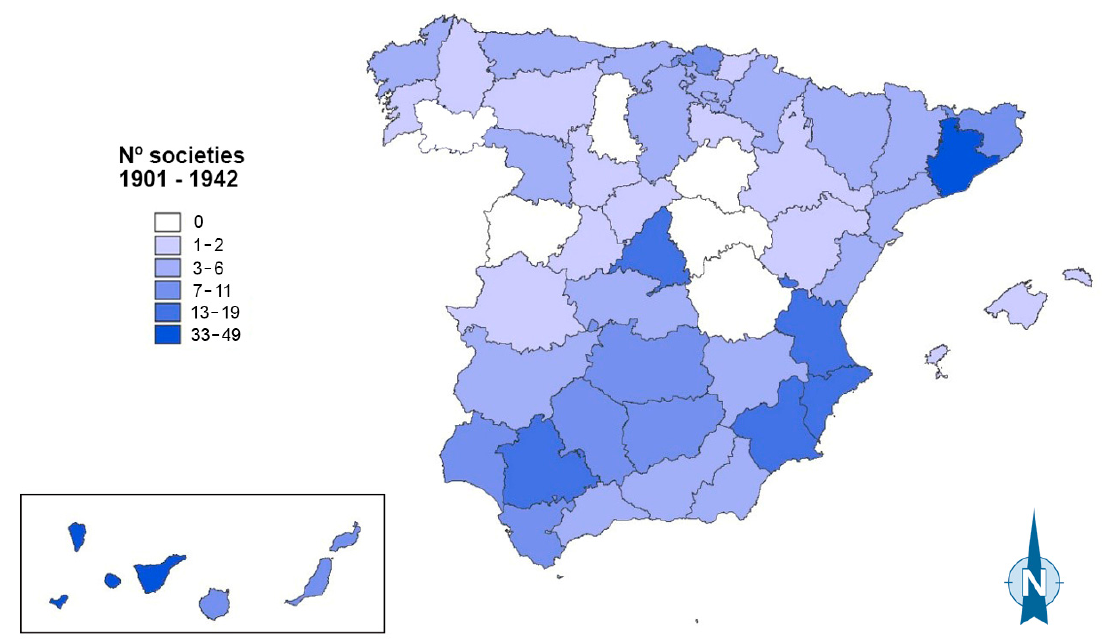
Figure 6. Regional distribution of water companies (1901–1942)